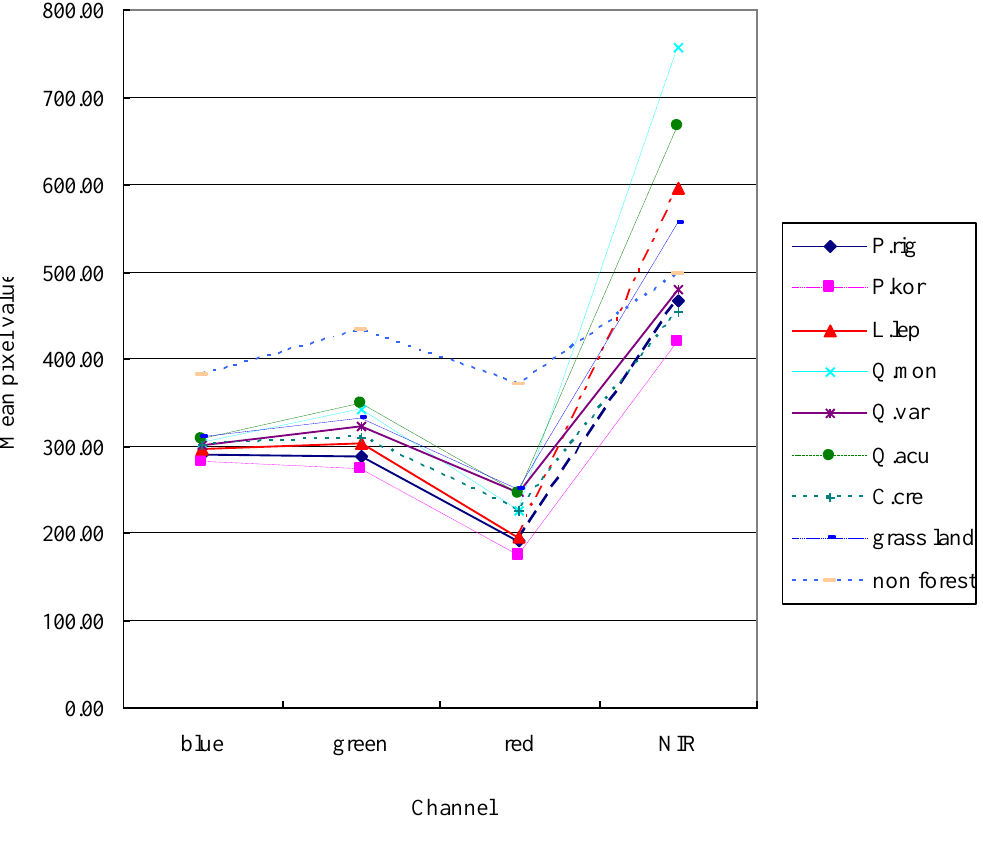
Figure 2. Average spectral signature of the IKONOS image for a selected training area of each class (P.rig: Pinus rigida , P.kor: Pinus koraiensis , L.lep: Larix leptolepis , Q.mon: Quercus mongolica , Q.var: Quercus variabilis , Q.acu: Quercus acutissima , C.cre: Castanea crenata , grass land, non